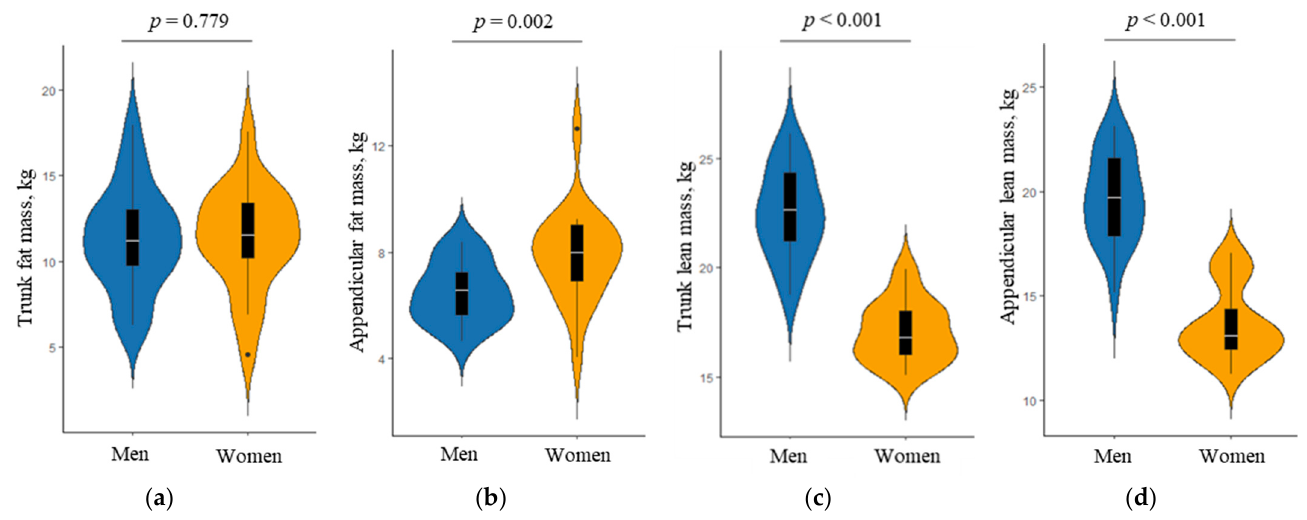
Figure 1. Comparison of segmental body composition as assessed by dual-energy X-ray absorptiometry between men and women: ( a ) trunk fat mass, ( b ) appendicular fat mass, ( c ) trunk lean mass, and ( d ) appendicular lean mass. The p value was obtained by the Mann–Whitney U test. Violin plots show the distribution of body composition in men and women. Overlaid box plots show medians, interquartile ranges, and spikes extending to the upper- and lower-adjacent values in each group.